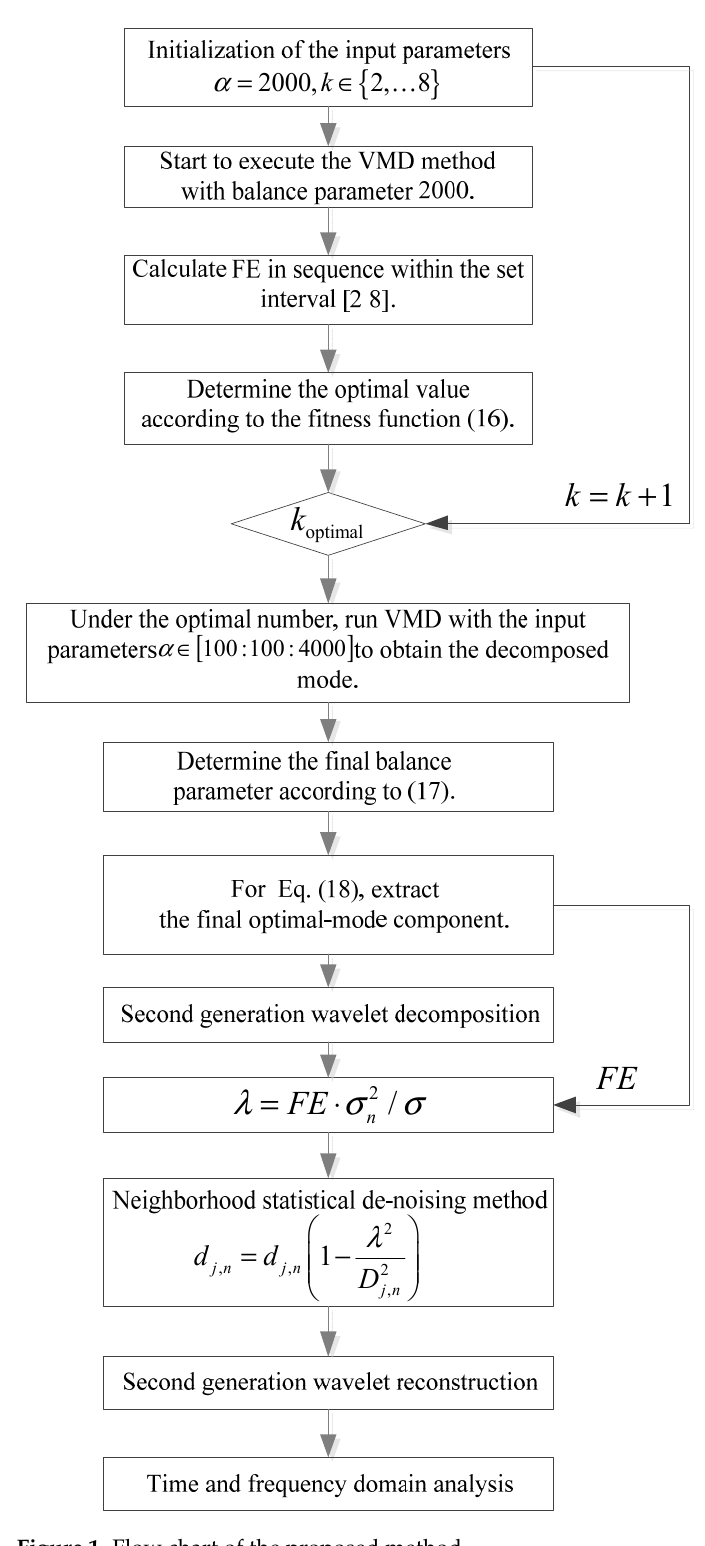
Figure 1. Flow chart of the proposed method.